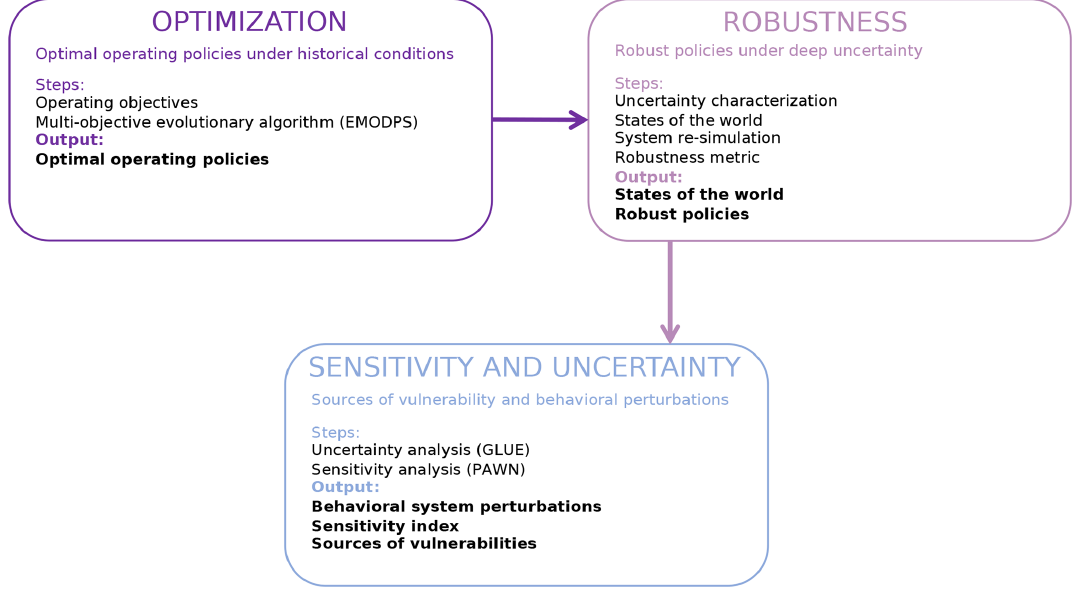
Figure 3. The integrated decision-analytic framework adopted in this study. Bold text identifies the output of a certain block which enters the subsequent